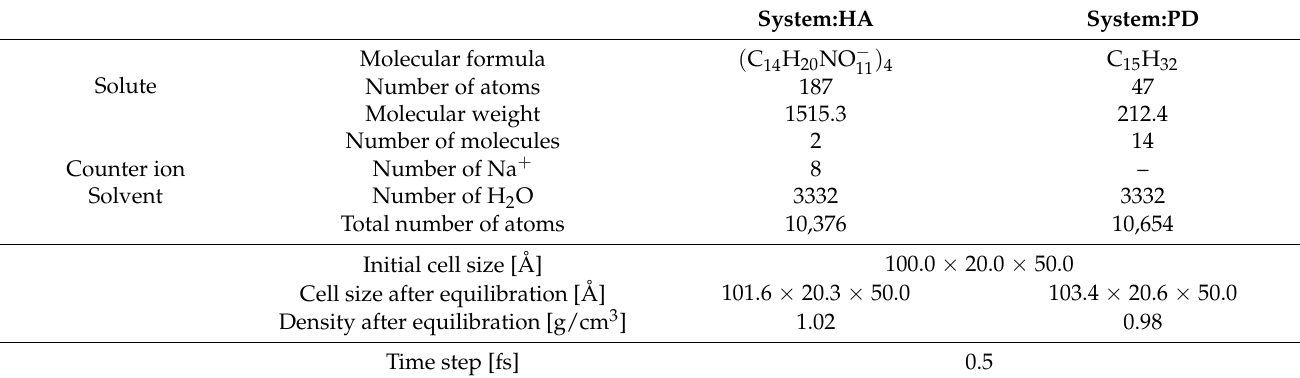
Figure 2. Snapshot of aqueous HA solution after equilibration at T = 298K and P = 1atm. The sys- tem contains two HA molecules (shown with van der Waals spheres), which appear to be fragmented due to the periodic boundary conditions. Water molecules are indicated with a wire model. Table 2. System parameters for the